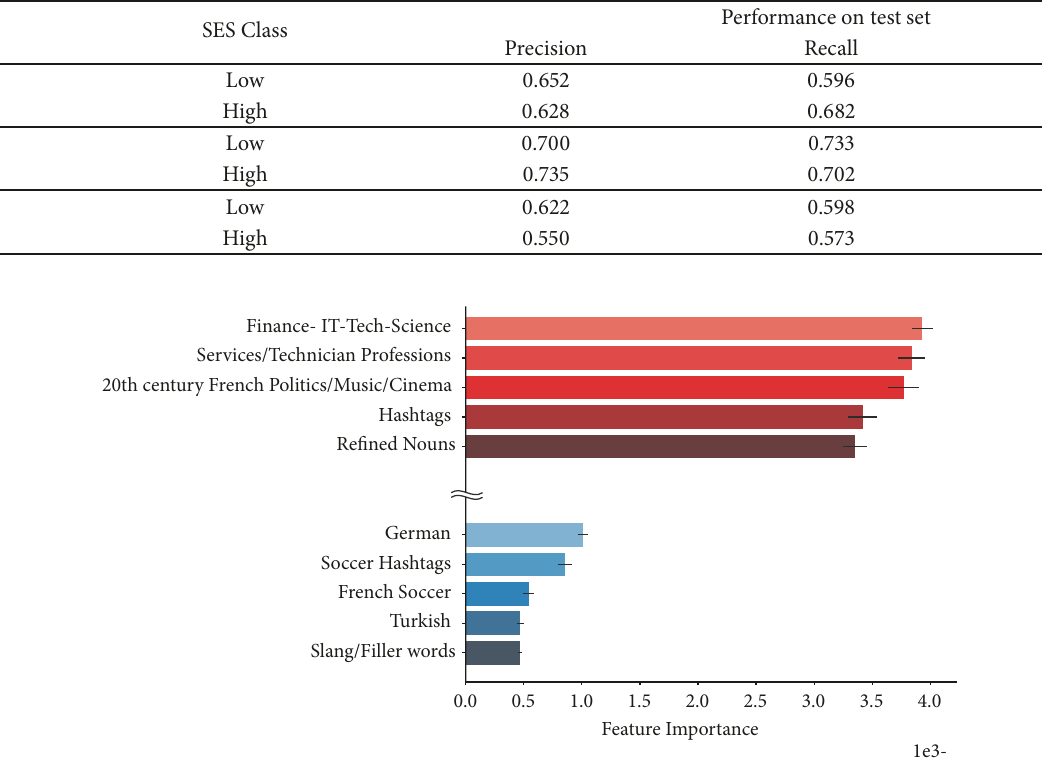
Figure10:Top(red)andbottom(blue)fivetopicsrankedintermsoftheirpredictiveperformanceintheXGBoostmodeltrainedonLinkedIn. Error bars indicate s.d. across the 10 cross-validation